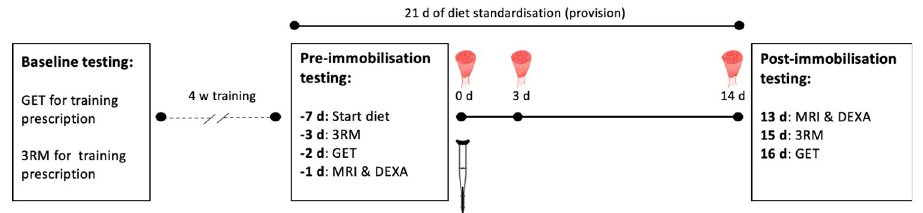
Fig 1. Study overview. Two primary testing phases were interspersed with a 14 d period of unilateral lower limb immobilization, and preceded by a 4 week exercise programme. Muscle biopsies were obtained from the vastus lateralis before, and at days 3 and 14 of immobilization. 3RM, 3 repetition maximum testing; Crutch icon, start of immobilization; GET, Graded exercise test [11]; DXA, Dual-energy X-ray absorptiometry; MRI, Magnetic resonance imaging; Muscle icon, muscle biopsy